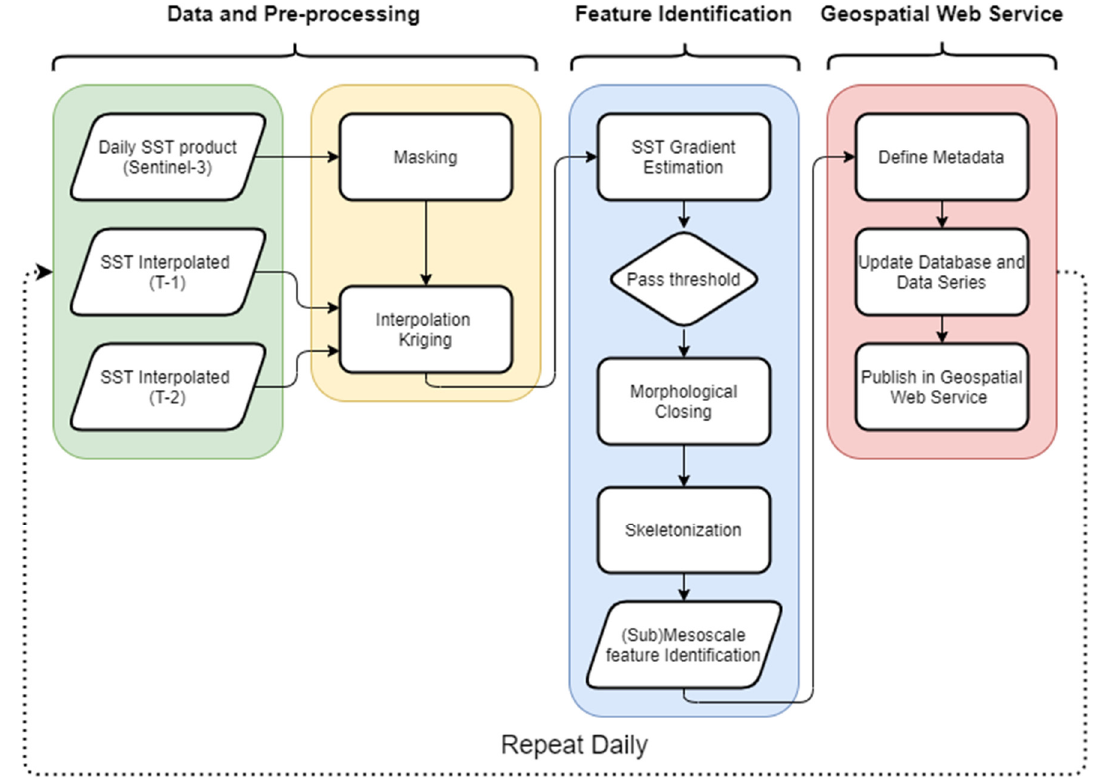
Figure 2. Flow chart describing the structure of the geospatial web service, from data processing to product publishing, where T is the day of the current date.